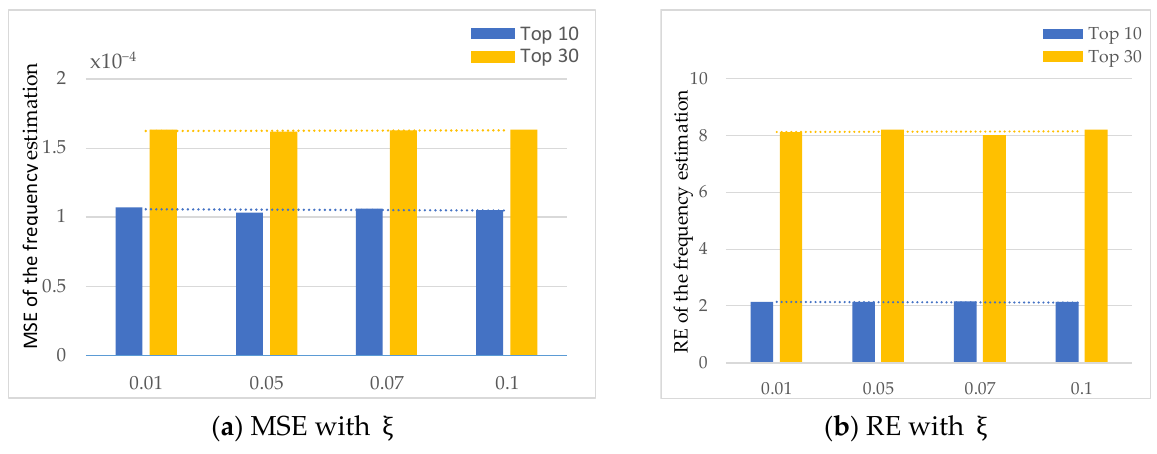
Figure 5. MSE and RE of the frequency estimation with different 𝜉